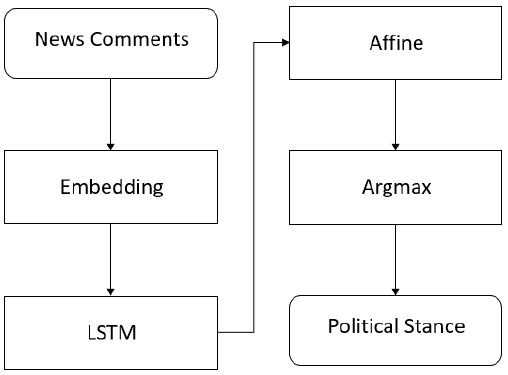
4 of 11 Table 3. Parameters of the proposed deep learning model. Parameter